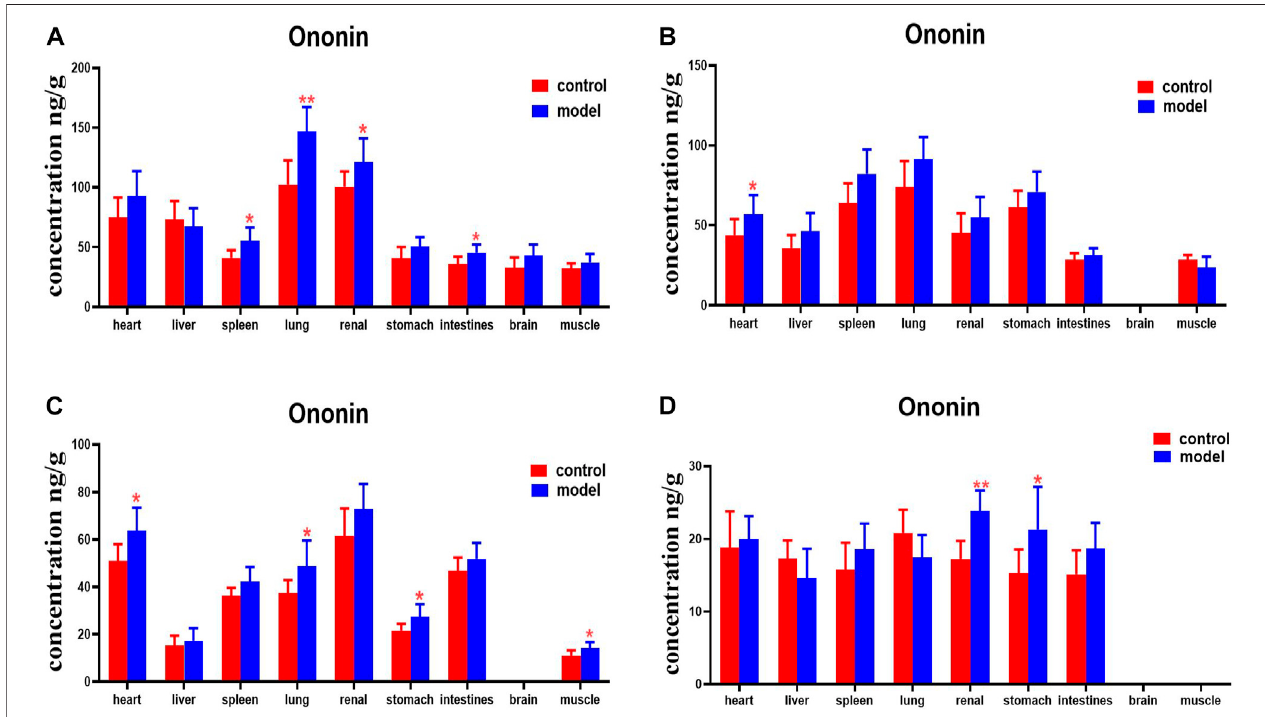
FIGURE 13 | Content of ononin in different mouse tissue homogenate of the normal and DN models at four different time points after intragastric administration of HQD (x±SD, n =8), (A) 30 min, (B) 2 h, (C) 4 h, (D) 8 h. Ps: * P < 0.05, ** P < 0.01 vs. normal group.